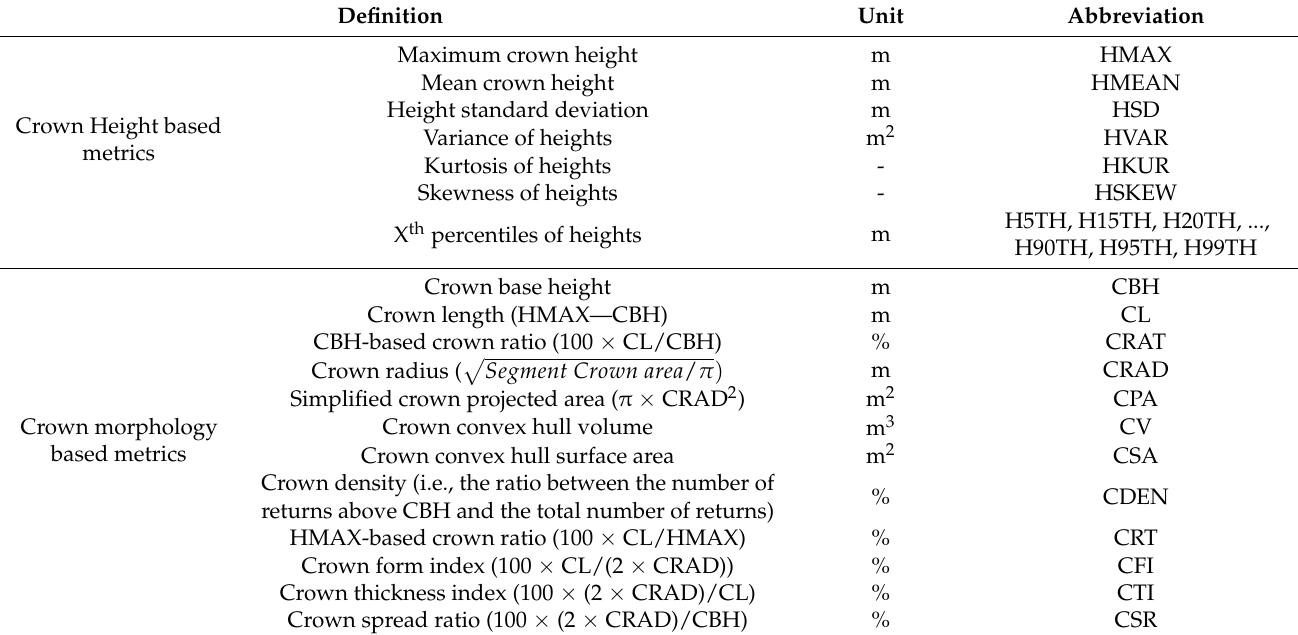
Table 3. ALS-derived crown metrics (Klauberg et al.